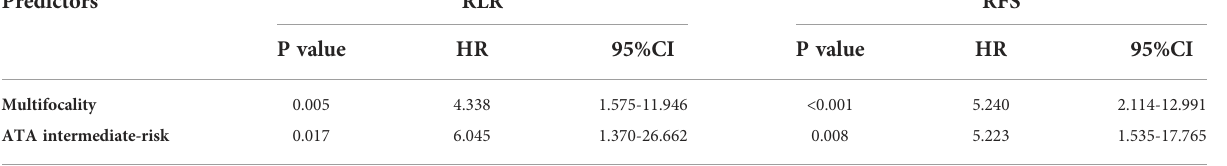
TABLE 4 Multivariate analysis of the predictive factors for RLR and